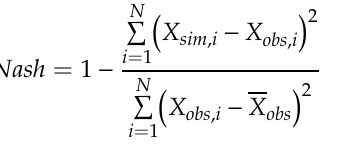
Figure 7. Discretization of solid boundary with two mesh sizes: 0.75 m and 0.1 m. Table 3. Nash coefficient of water level. Z up (m)